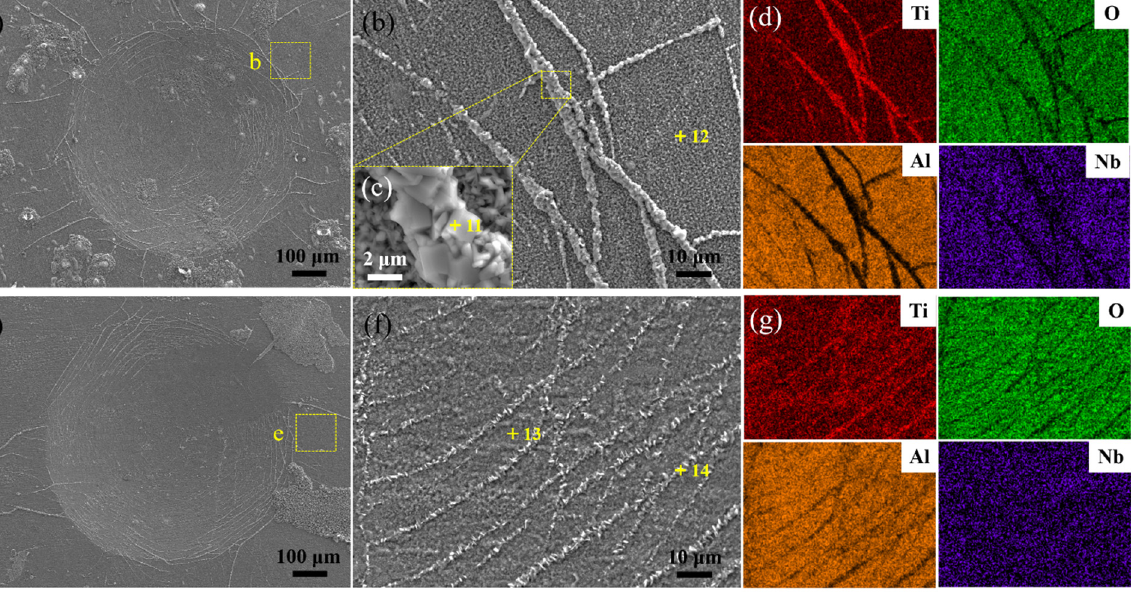
Figure 7. ( a , e ) The impressions of specimens after the oxidation for 2 h and 100 h at 1000 ◦ C, ( b , f ) their local SEM images, ( c ) the inset marked by yellow square frame in ( b ) and ( d , g ) the corresponding EDS mapping results.